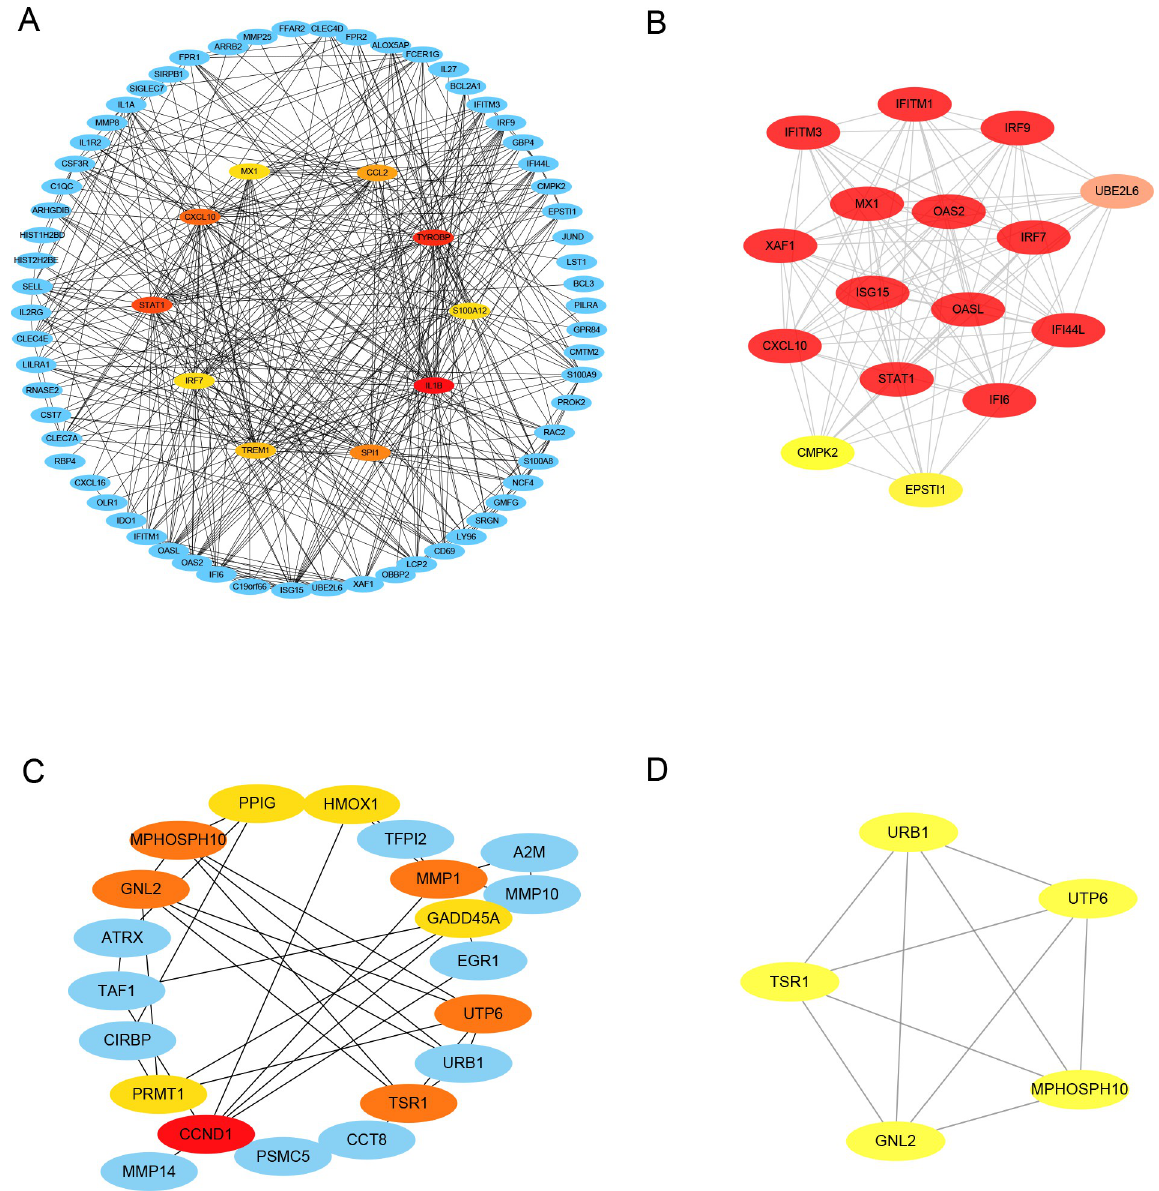
Fig 6. Identification of hub genes from PPI network using Cytoscape plugins Cytohubba and MCODE. A: Hub genes identified among upregulated genes using Cytohubba plugin in Cytoscape software. B: Hub genes identified among upregulated genes using MCODE plugin in Cytoscape software. C: Hub genes identified among downregulated genes using Cytohubba plugin in Cytoscape software. D: Hub genes identified among downregulated genes using MCODE plugin in Cytoscape software.